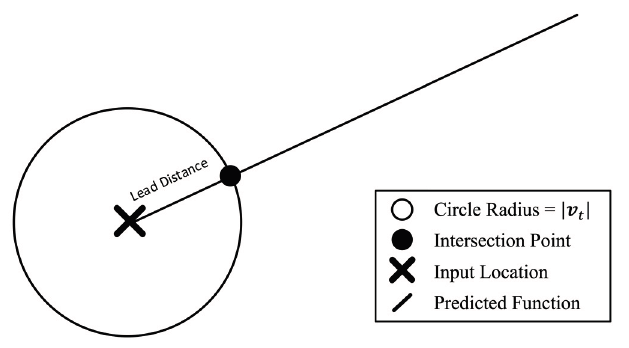
Figure 4. Locating the next GPS point using the intersection of the circle with the predicted function, where the circle has a radius equal to the desired lead